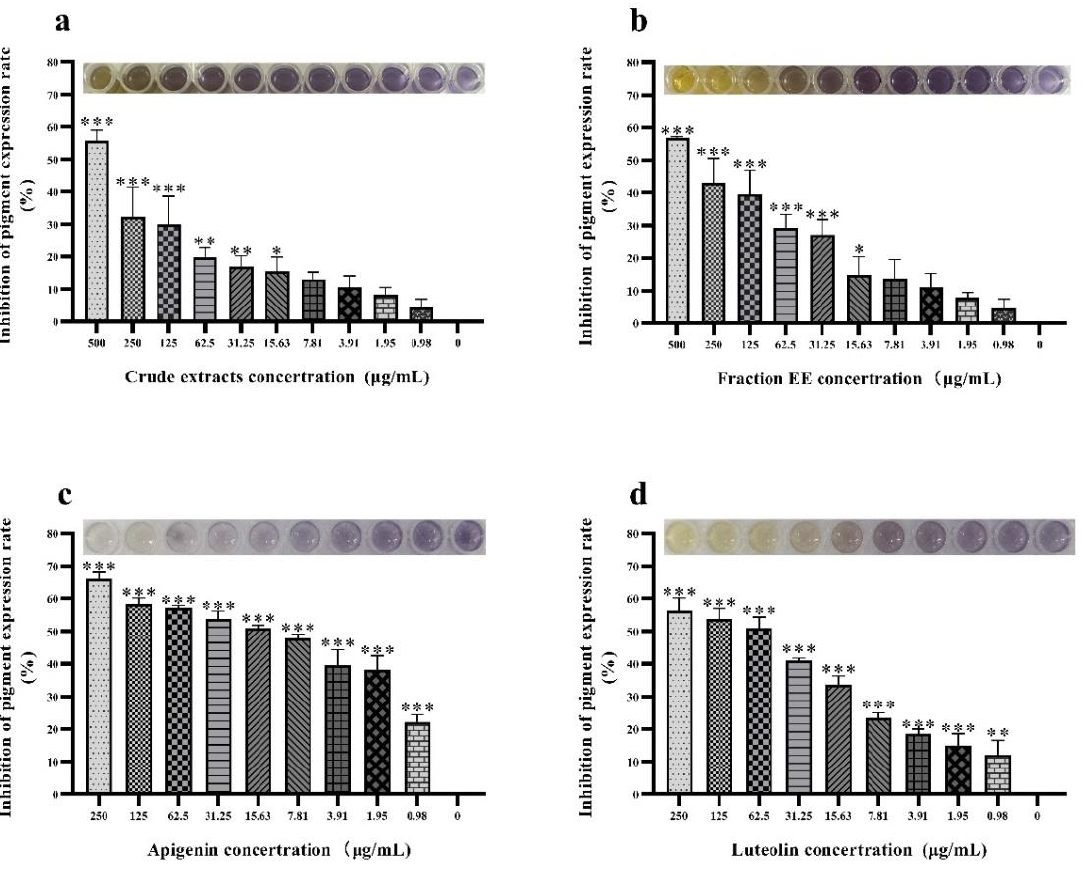
Figure 2. The G. hypoleucum DC. extract and two compounds isolated from it showed an inhibitory effect on violacein production by C. violaceum . In ( a ) and ( b ), violacein inhibition by C. violaceum was tested at OD 585 in the presence of crude extracts and ethyl acetate partition (fraction EE) (mg/mL), respectively, at 30 °C after 24 h in 96-well plates. ( c – d ) Luteolin and apigenin separated from fraction EE significantly inhibited violacein production in a concentration-dependent manner, respectively. Inhibition of pigment expression rate was calculated using the following formula: Inhibition% = treated OD 585 /control OD 585 × 100%. Columns represent means ± standard deviations, Statistically significant differences (determined by Student ’ s t -test) are indicated as *** p < 0.001, ** p < 0.01, and * p < 0.05 vs. the control group. 2.4. Anti-Biofilm Activity of Luteolin and Apigenin on C. Violaceum